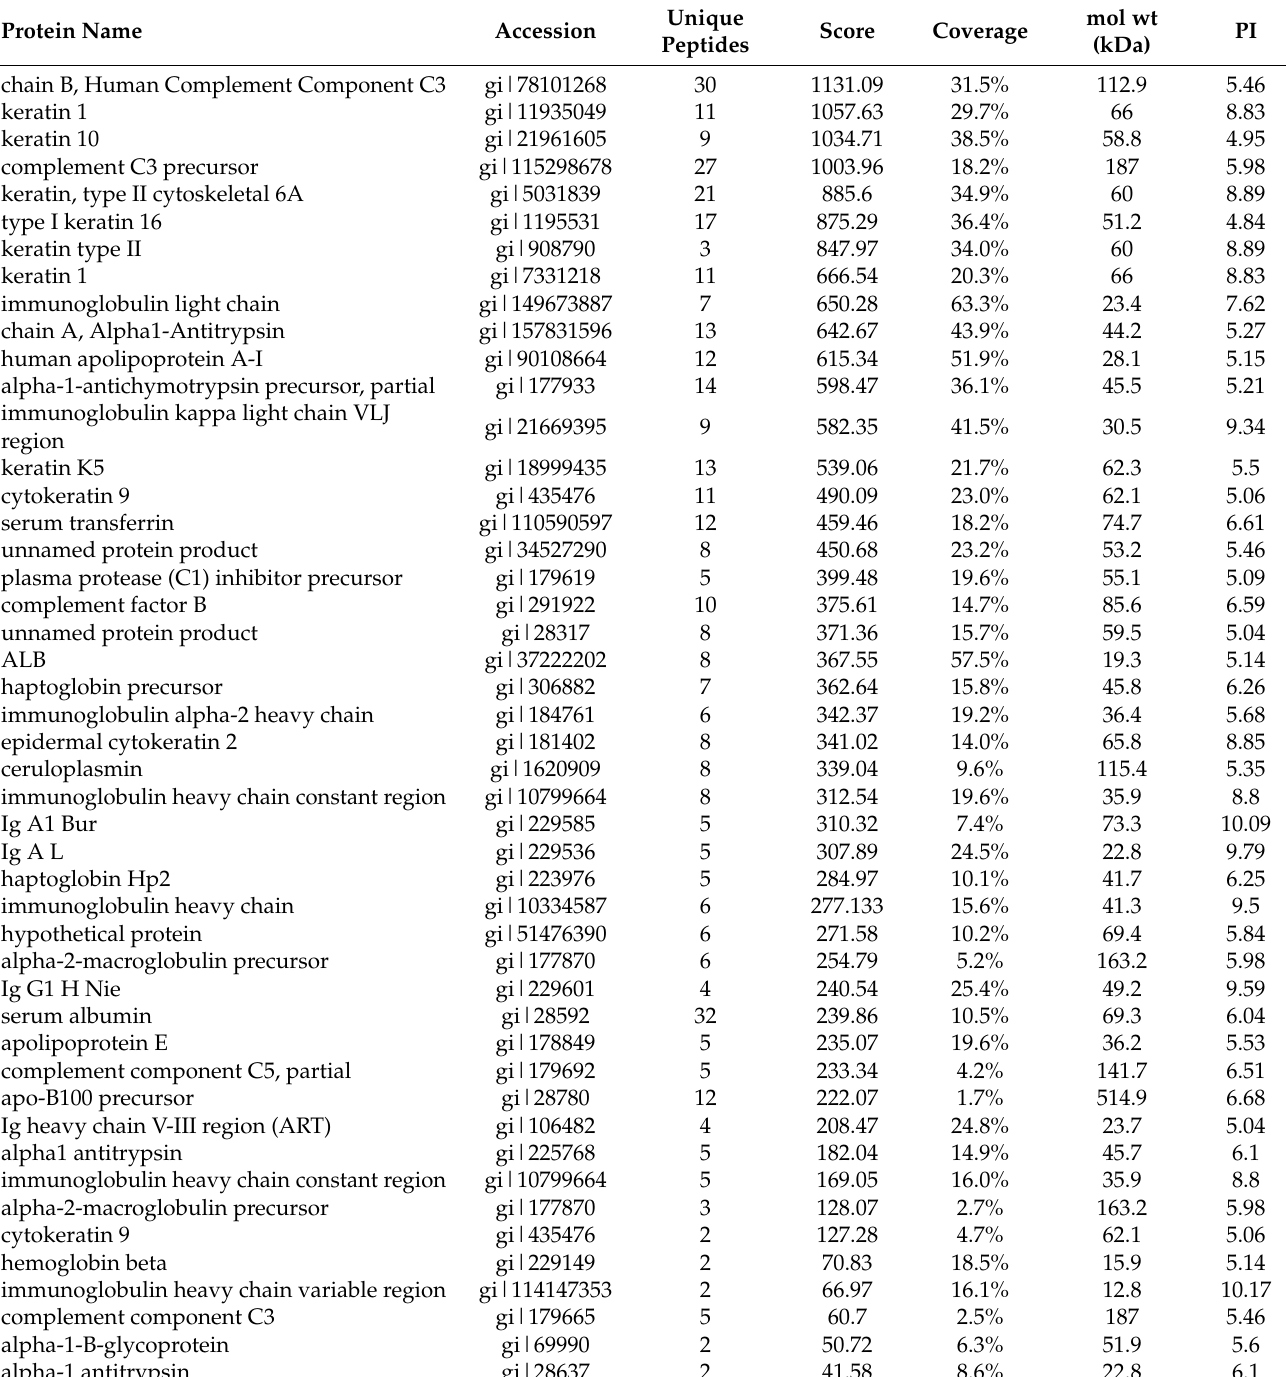
Table 2. Identification of glycoproteins with bisecting GlcNAc in PC patients’